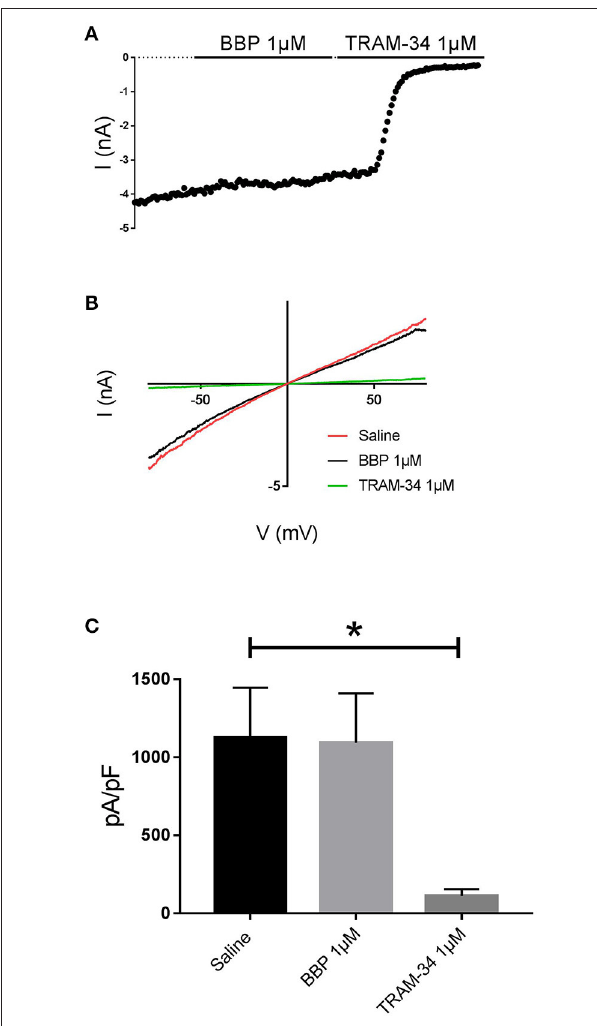
FIGURE 4 | Effect of BBP 1 µ M on hBK ( n = 8). Representative current-time plot (A) and its corresponding current-voltage plot (B) depicting the effect of BBP 1 µ M and the specific BK inhibitor paxilline 3 µ M. The column graph (C) compares the effects of both BBP and paxilline with the control current. BK current was inhibited by 19 ± 6% upon application of BBP 1 µ M. * p <